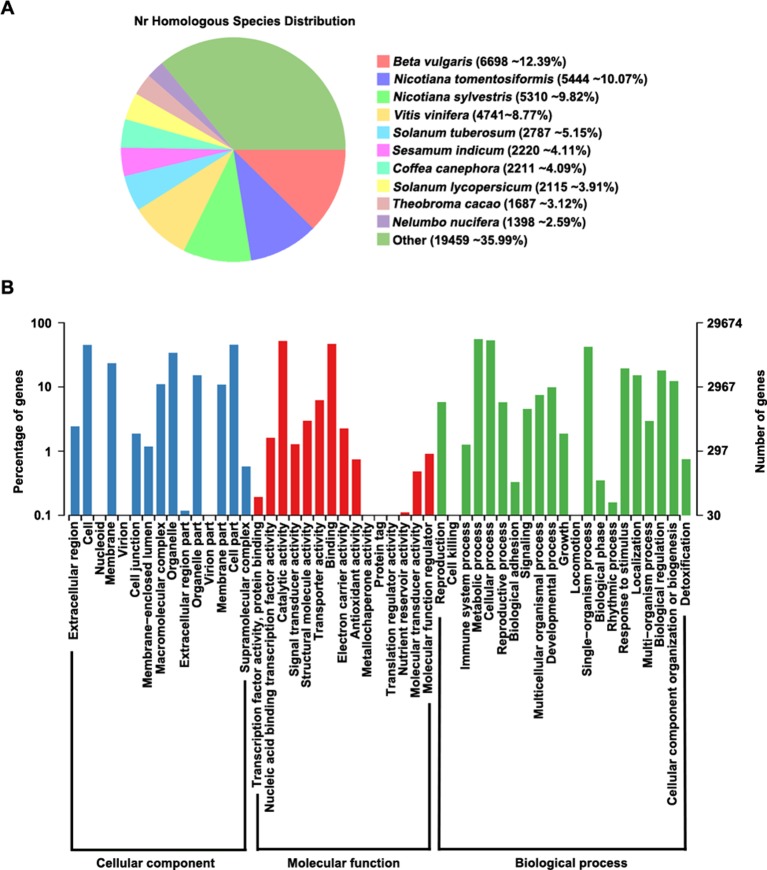
Gene annotation in P. cuspidatum. (A) Sequence alignment of all genes against the nr database. The proportions of genes with the closest homologs in different species are shown. (B) GO annotation of genes in P. cuspidatum. The GO terms were categorized into three different groups, including cellular component, molecular function, and biological process.